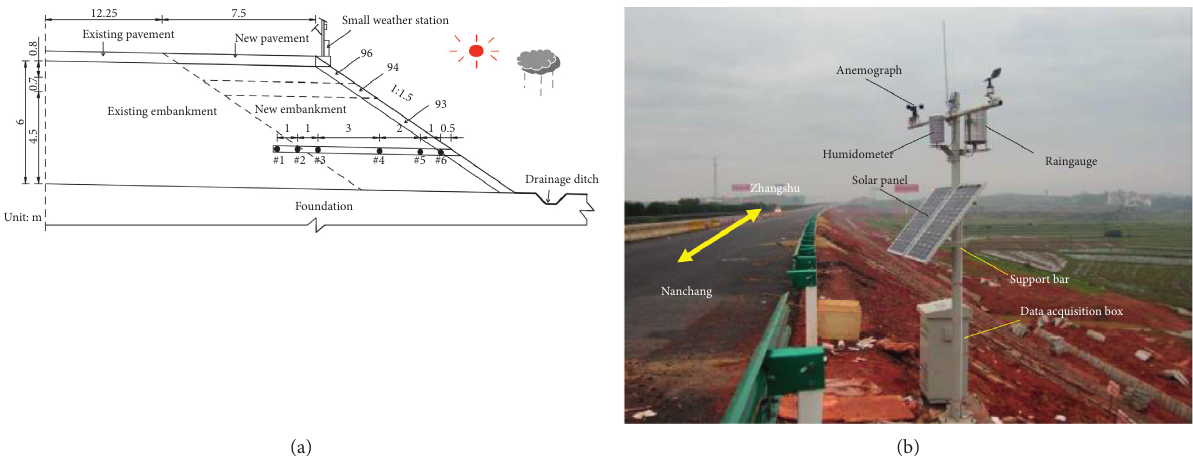
Figure 2: Field measurement system of the new embankment: (a) installation sketch of the FDR sensors; (b) photograph of the small weather station